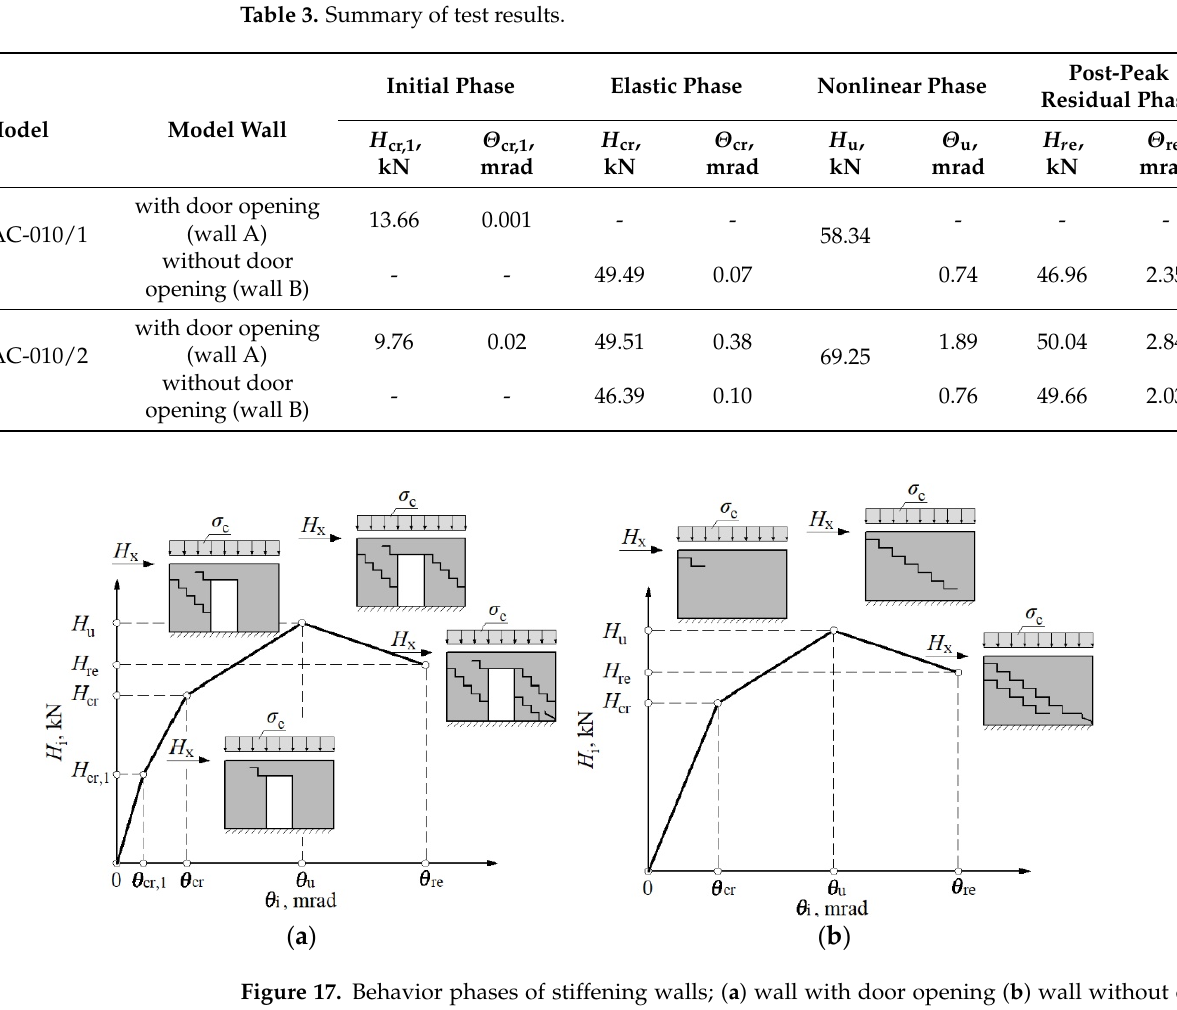
Table 3. Summary of test results.